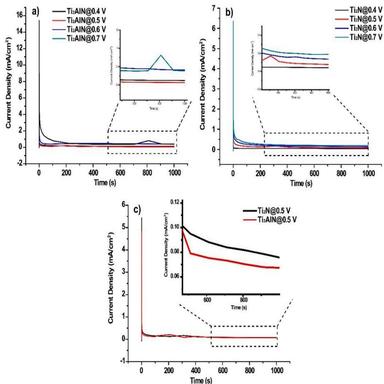
CA curves of a) Ti2AlN and b) Ti2NTx at varying potential while c) comparison of Ti2AlN and Ti2NTx at 0.5 V potential in 1 M NaOH+0.02 M N2H4.